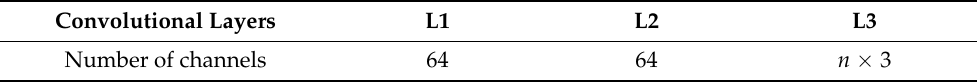
Table 2. The number of channels in each convolutional layer of the weight prediction